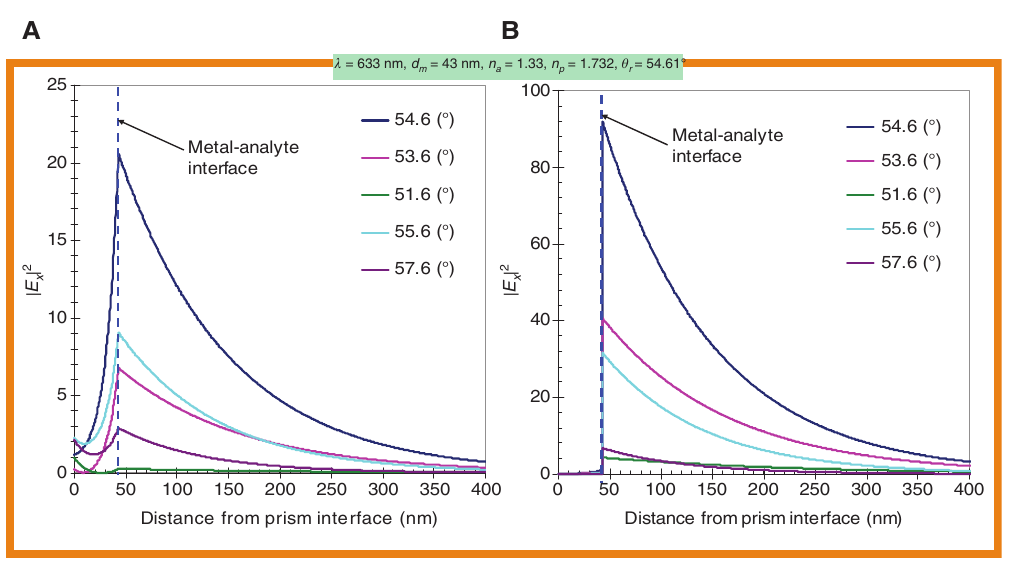
Figure 4: Simulated field component ( x and z ) intensity distribution for the case of silver film on top of a prism and water analyte adjacent to the silver as a function of the distance from the prism interface: (A) | E The parameters are shown on the top and the resonance angle obtained with the structure is 54.61 ° . Reproduced with permission from Reference [55].